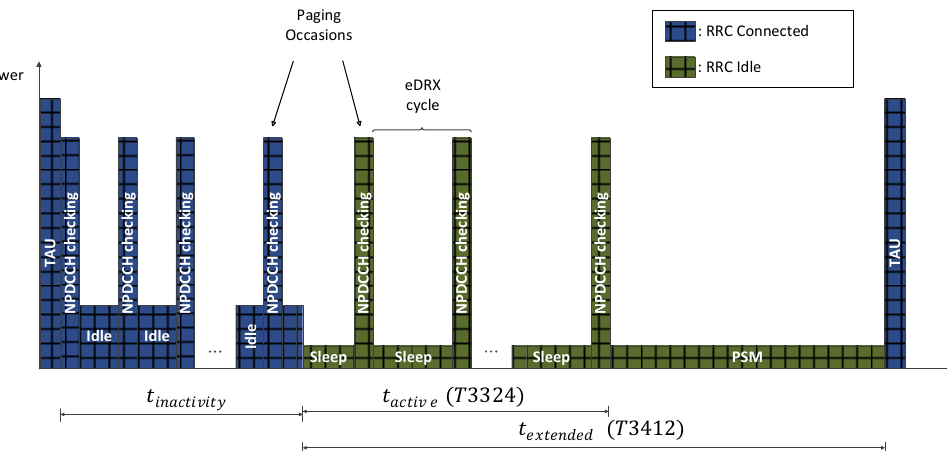
Figure 3. Paging cycles for a UE when eDRX feature is active.